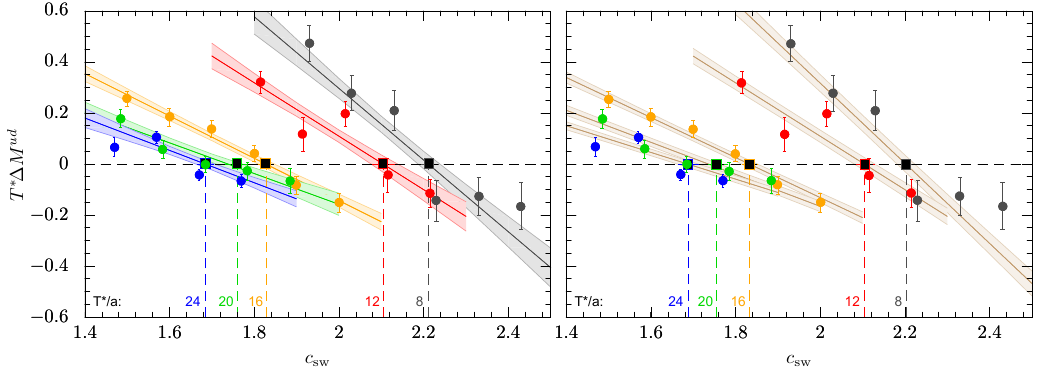
ud = 0 individually at each T (cid:3) (cid:1) M (cid:3) =a (left), or